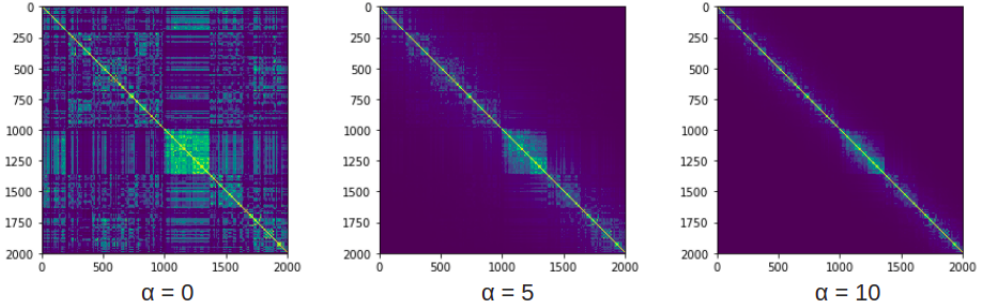
Figure 4. Effect of α (from left to right 0, 5, and 10) on similarity matrix S ij . Higher values of α enforce temporal connections between nearby frames and increase the quality of the detected shots.